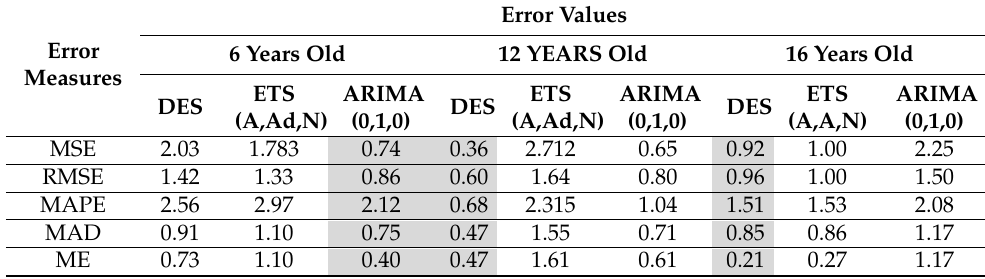
Table 3. Comparison of forecast accuracy for one-step-ahead cross-validation